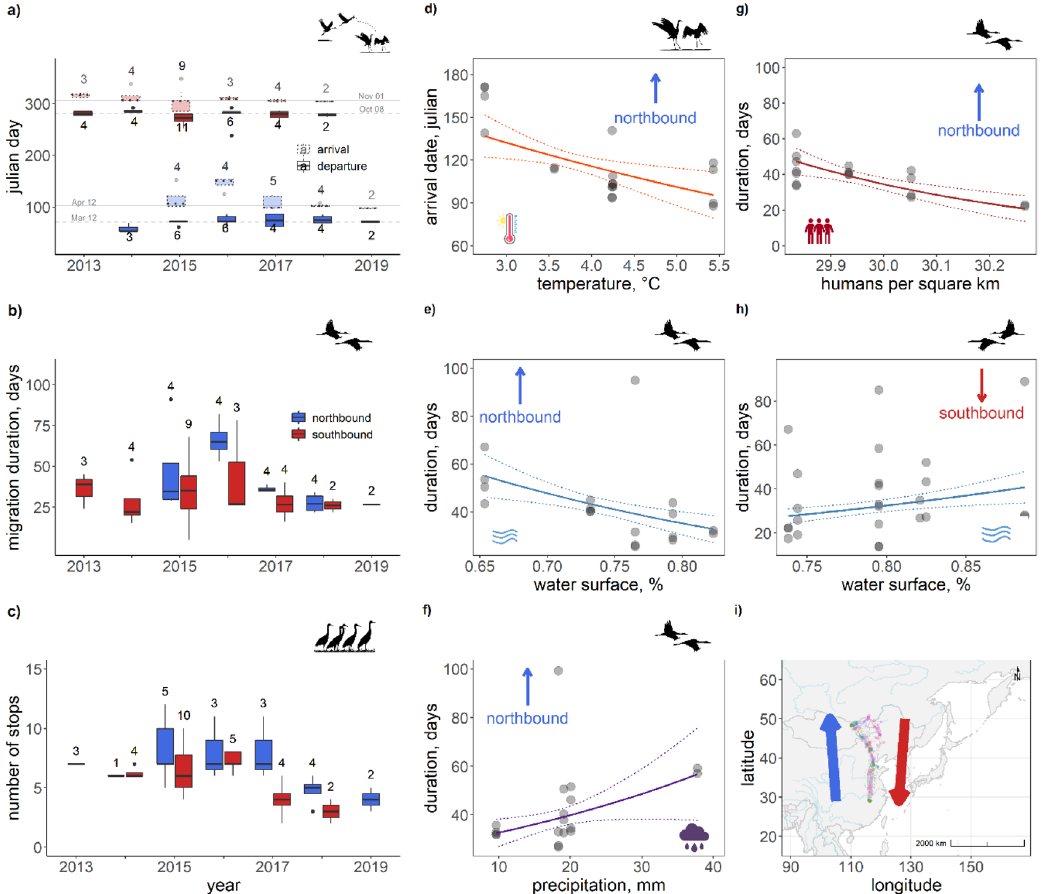
Figure 3. The migratory performance across the seven years of the study and their relationship with significant explanatory variables in WNCs. In panels ( a – c ), boxplots of arrival and departure dates, migration duration and number of stops as a function of year are plotted. The number of birds are indicated. Red and blue box plots refer to southbound and northbound migration respectively (cf panel i ). In panels ( d – h ) significant relationships of these migratory performance indices with environmental factors are depicted (cf. Appendix Table A4), using the partial residuals of the response variables and depicting the marginal effect response curve for each relationship. The map and figures were generated in RStudio v2022.02.2 (http:// www. rstud io. com) 61